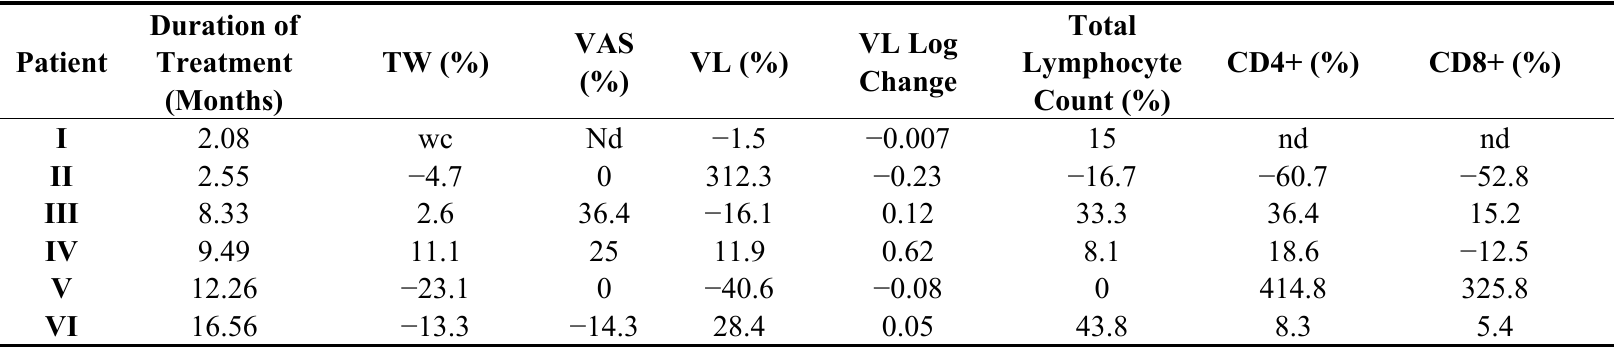
Table 4. Percent change in clinical and laboratory parameters when tenofovir treatment was stopped compared to baseline